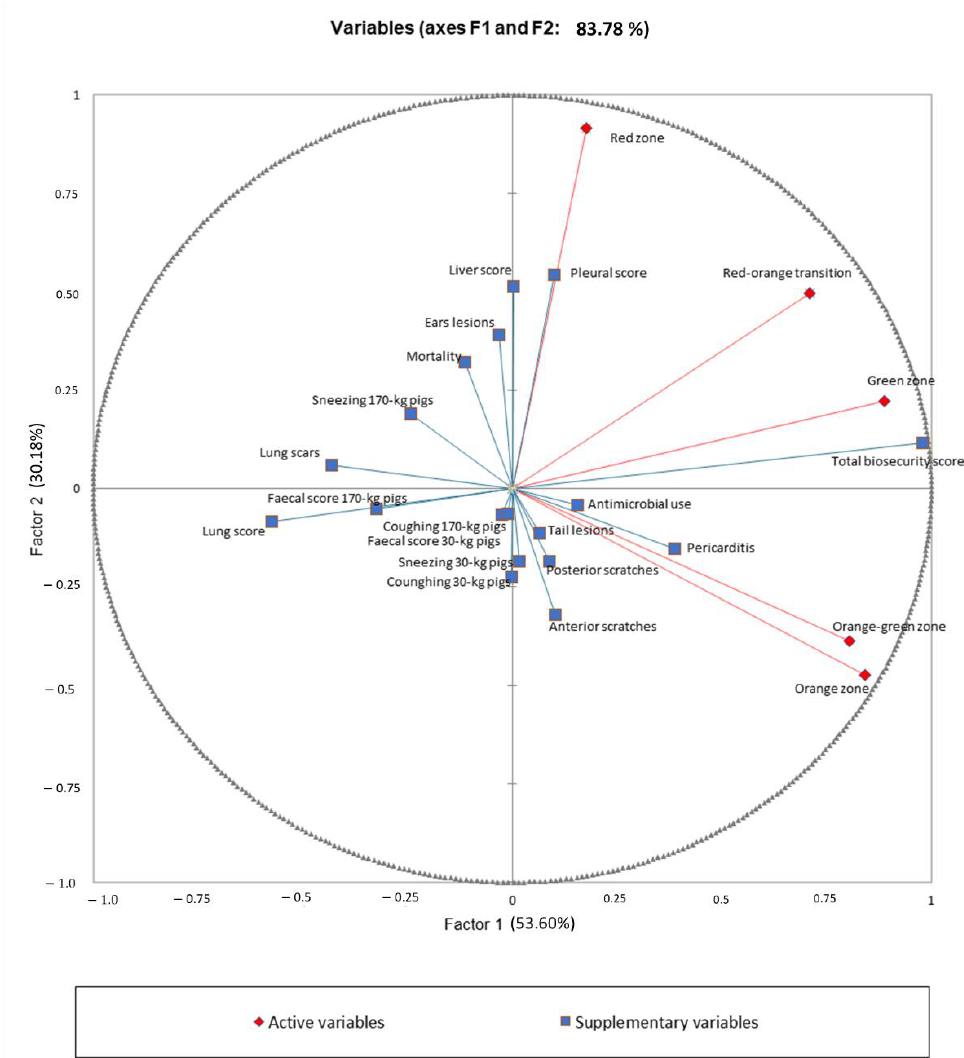
Figure 2. Correlation circle of the PCA analysis. Active variables are changes in biosecurity scores in each zone after 12 months, and are represented in red; red-public zone, red/orange-public/professional transition, orange-professional zone, orange/green-professional-herd transition, and green-herd zone. Supplementary variables are represented in blue. Table 4. Changes in biosecurity scores after 12 months and biomarker evolution in the four clusters